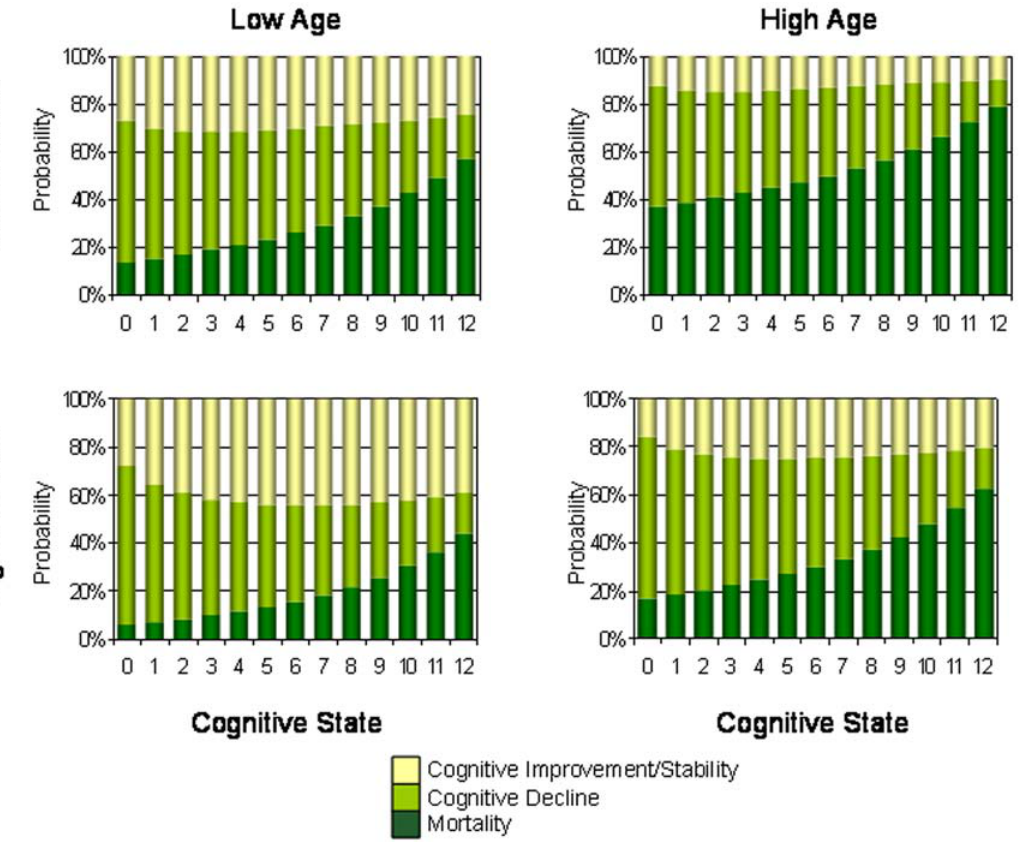
Figure 3. Changes in cognition in relation to baseline cognitive status at baseline by age and exercise level for people with lower levels of education.